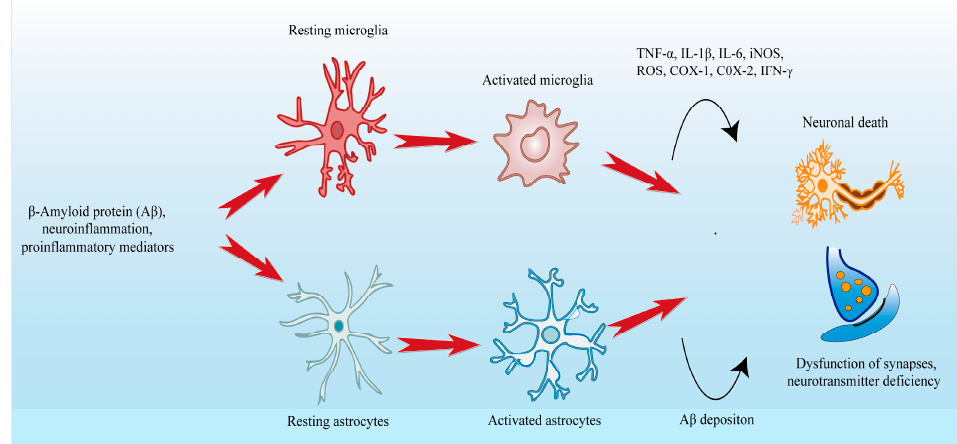
Figure 2. Mechanism of glial cells aggravating inflammatory response in brain